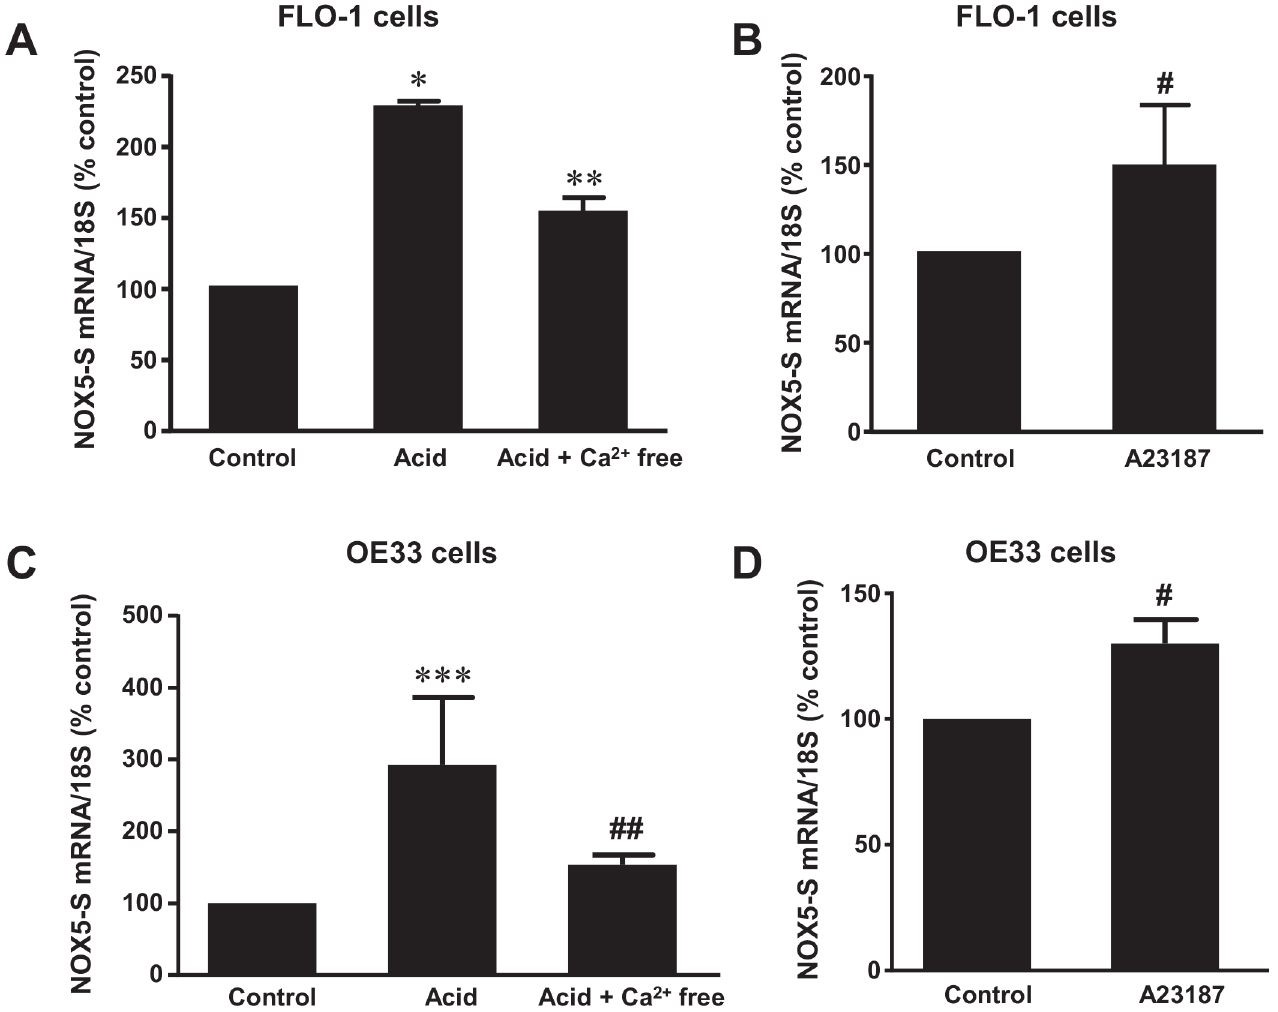
Fig 7. Role of calcium in acid-induced NOX5-S expression. A. Acid treatment (pH 4.0, 1 hour) significantly increased NOX5-S expression in FLO-1 cells, an increase which was blocked by the removal of calcium with calcium free medium plus 1 mM EGTA and 1 μ M thapsigargin, B) A23187 significantly increased NOX5-S mRNA expression in FLO-1 cells. C. Acid treatment (pH 4.0, 1 hour) significantly increased NOX5-S expression in OE33 cells, an increase which was blocked by the removal of calcium with calcium free medium plus 1 mM EGTA and 1 μ M thapsigargin, B) A23187 significantly increased NOX5-S mRNA expression in OE33 cells. The data suggest that acid-induced NOX5-S expression may be dependent on intracellular calcium increase. N = 3, ANOVA * P < 0.02 & *** P < 0.01 compared with control group; ** P < 0.01 & ## P < 0.05, compared with acid group; paired t test # P <